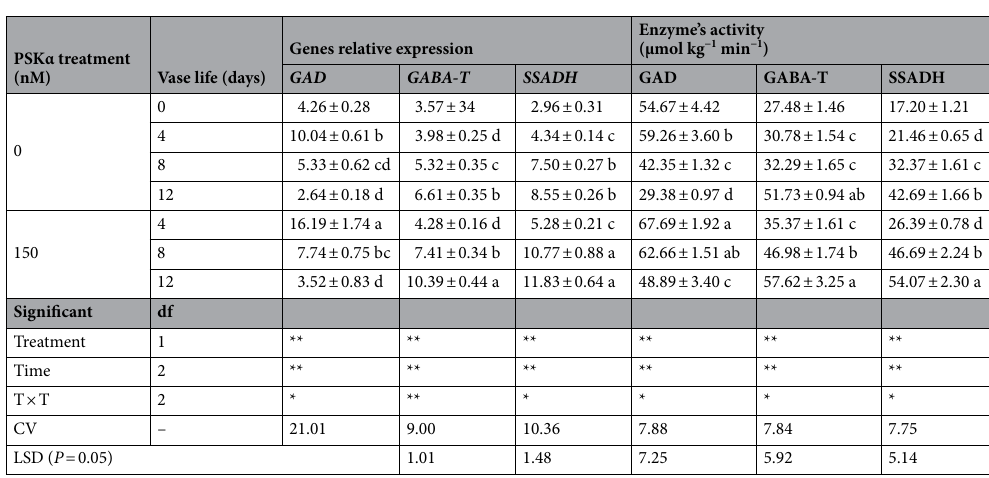
Table 7. GAD , GABA-T and SSADH genes expression and enzymes activity in petals of rose flowers treated with PSKα at 0 and 150 nM during vase life at 20 °C for 12 days. Data shown are mean values of n = 3, and the error bars represent standard errors of the means. Mean values followed by different letters indicate they are different by LSD test at P < 0.05.